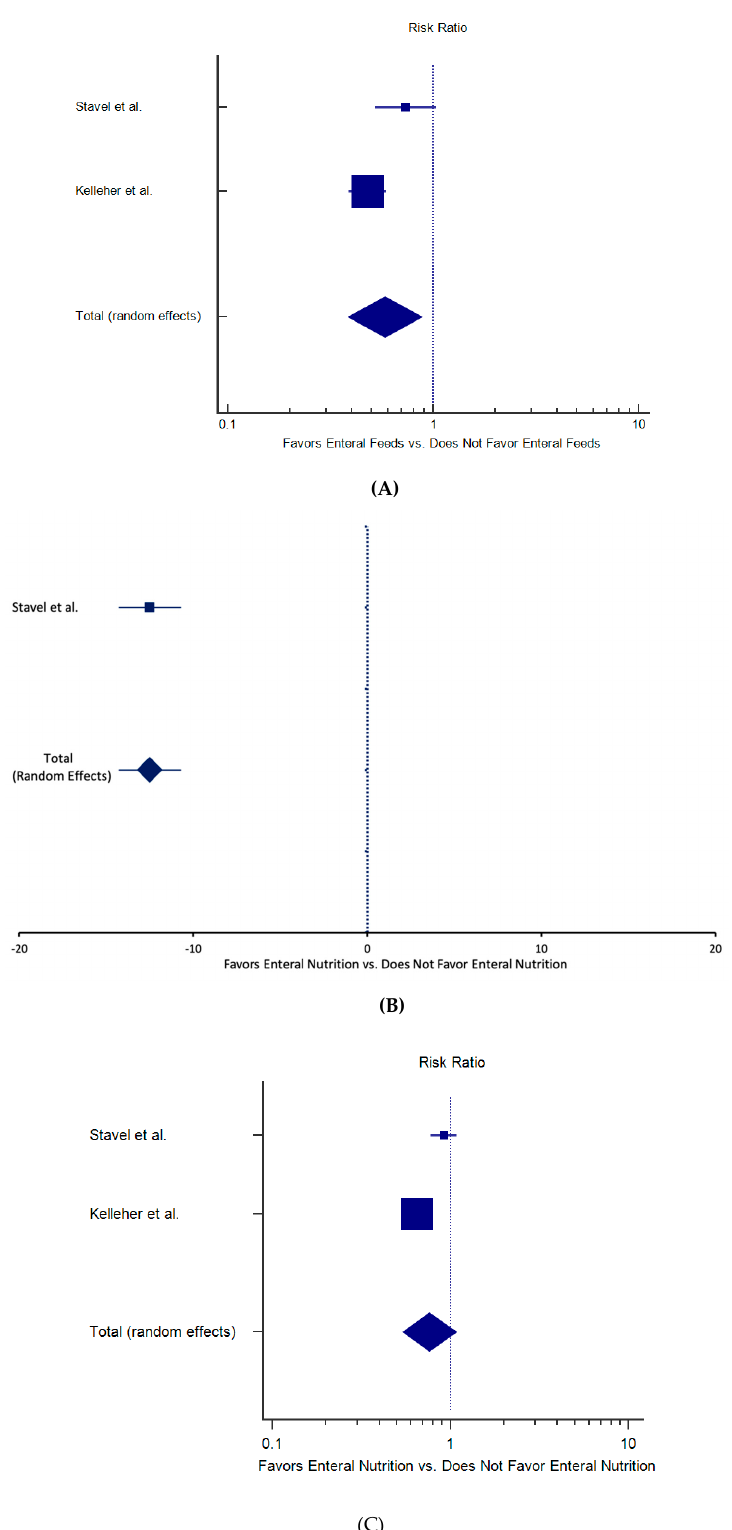
Figure 2. Relative risk and outcomes reported in selected studies. (A) Early Nutrition and SIP Incidence; (B) Early Nutrition and LOS; (C) Early Nutrition and overall mortality.